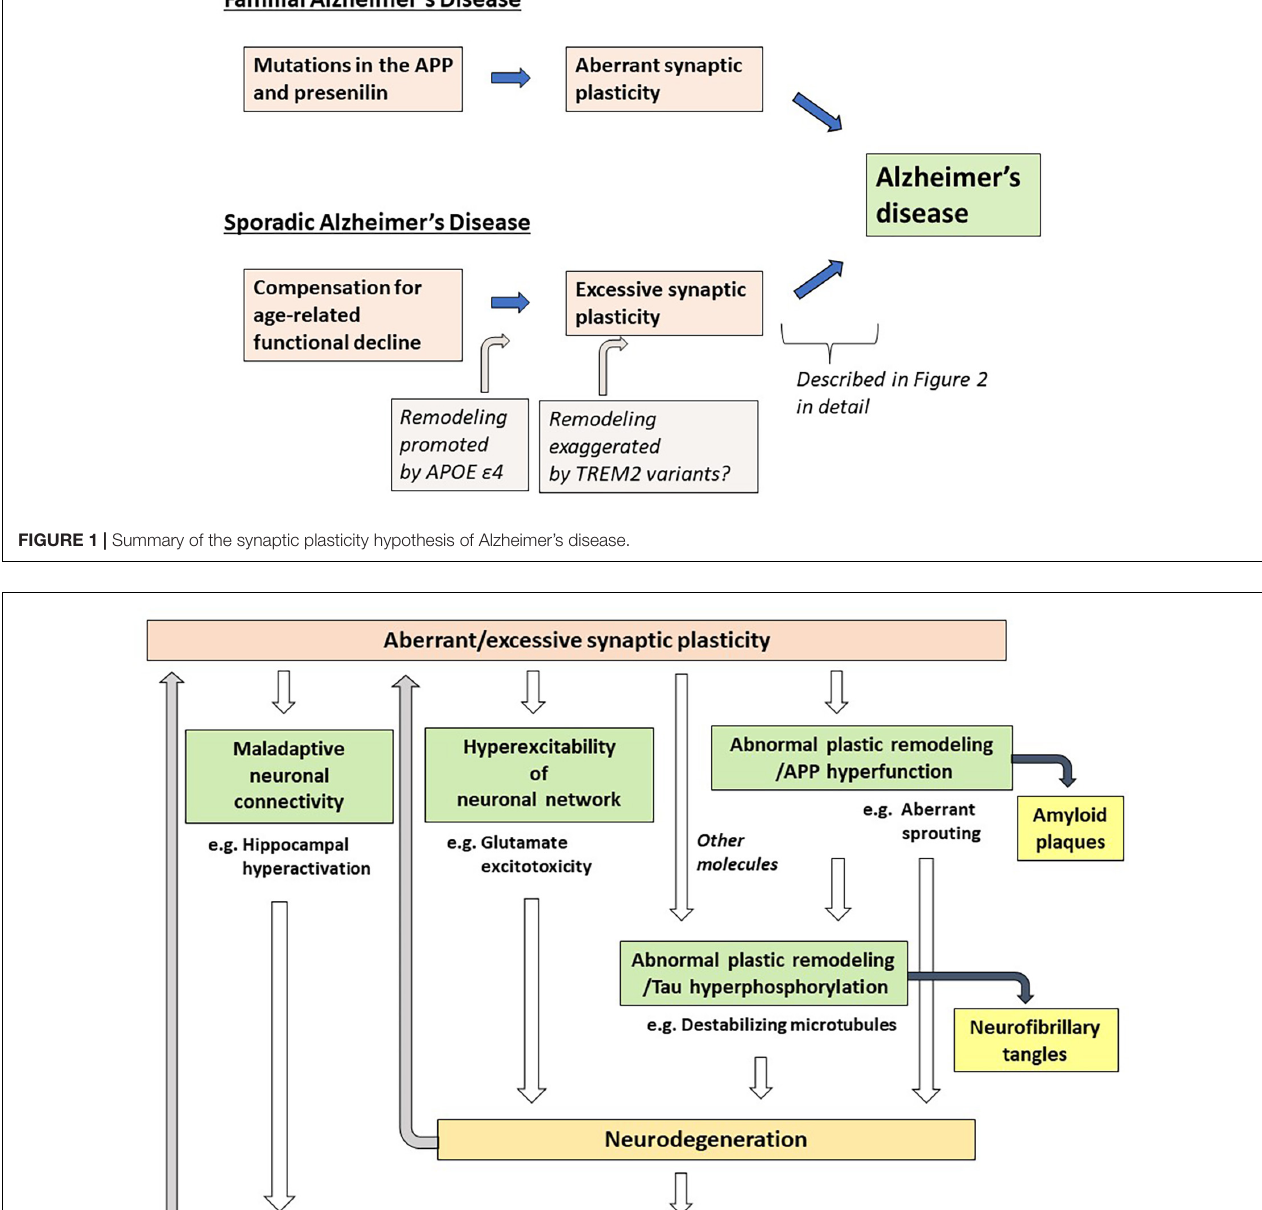
Frontiers in Aging Neuroscience |